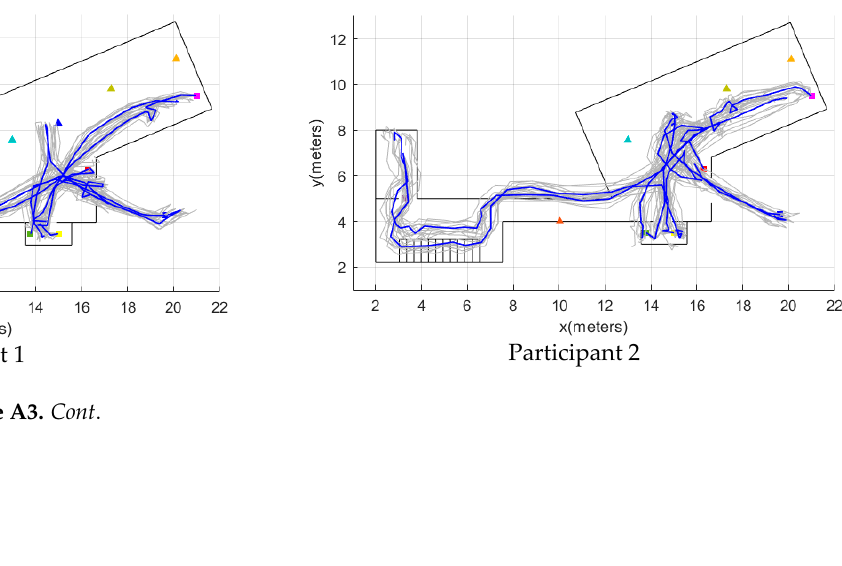
Figure A2. Indoor localization results (Older adults’ group, participants 7–11).